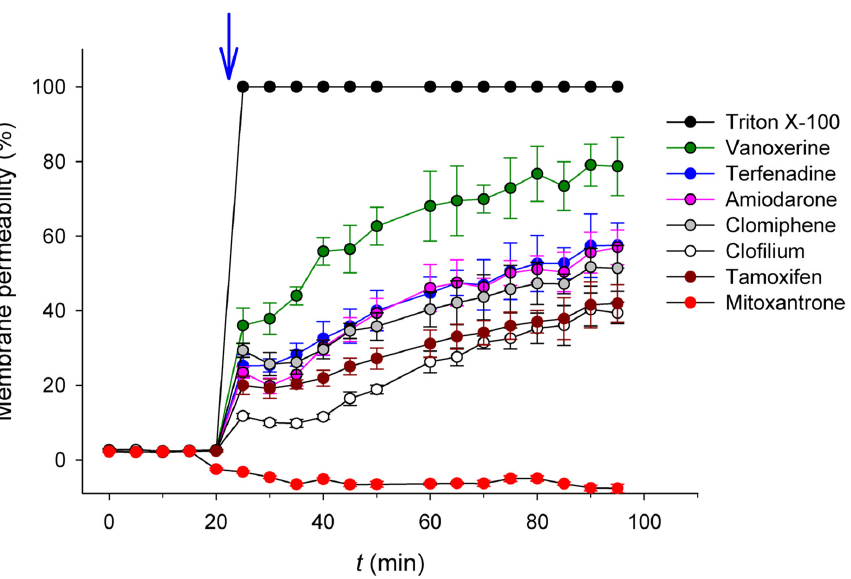
Figure 4. Evaluation of the membrane permeability of the pneumococcal cells upon the addition of compounds (25 µM). The arrow indicates the time of addition.